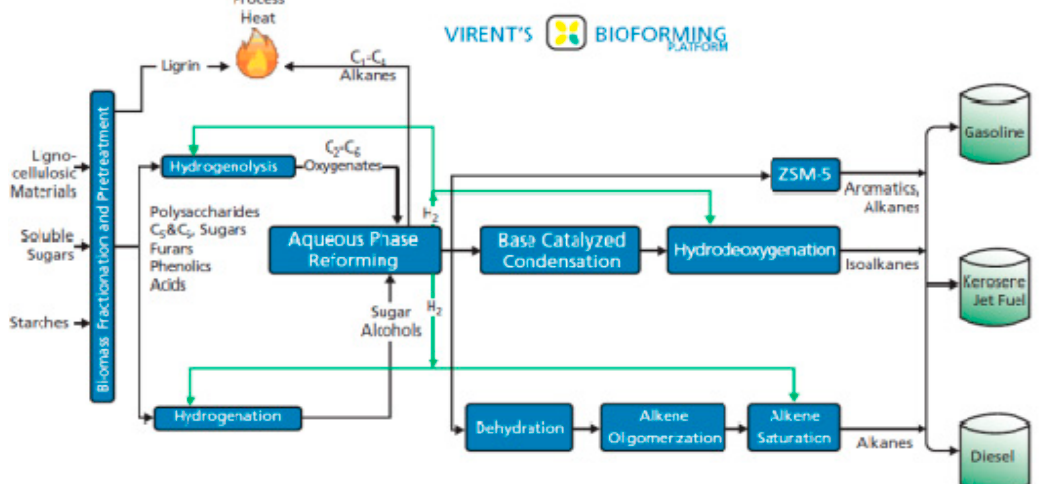
Figure 4. Virent’s BioForming ® platform for the production of renewable transportation fuels from biomass feedstocks [120]. Reproduced with permission from [120]. Virent: Copyright 2008.